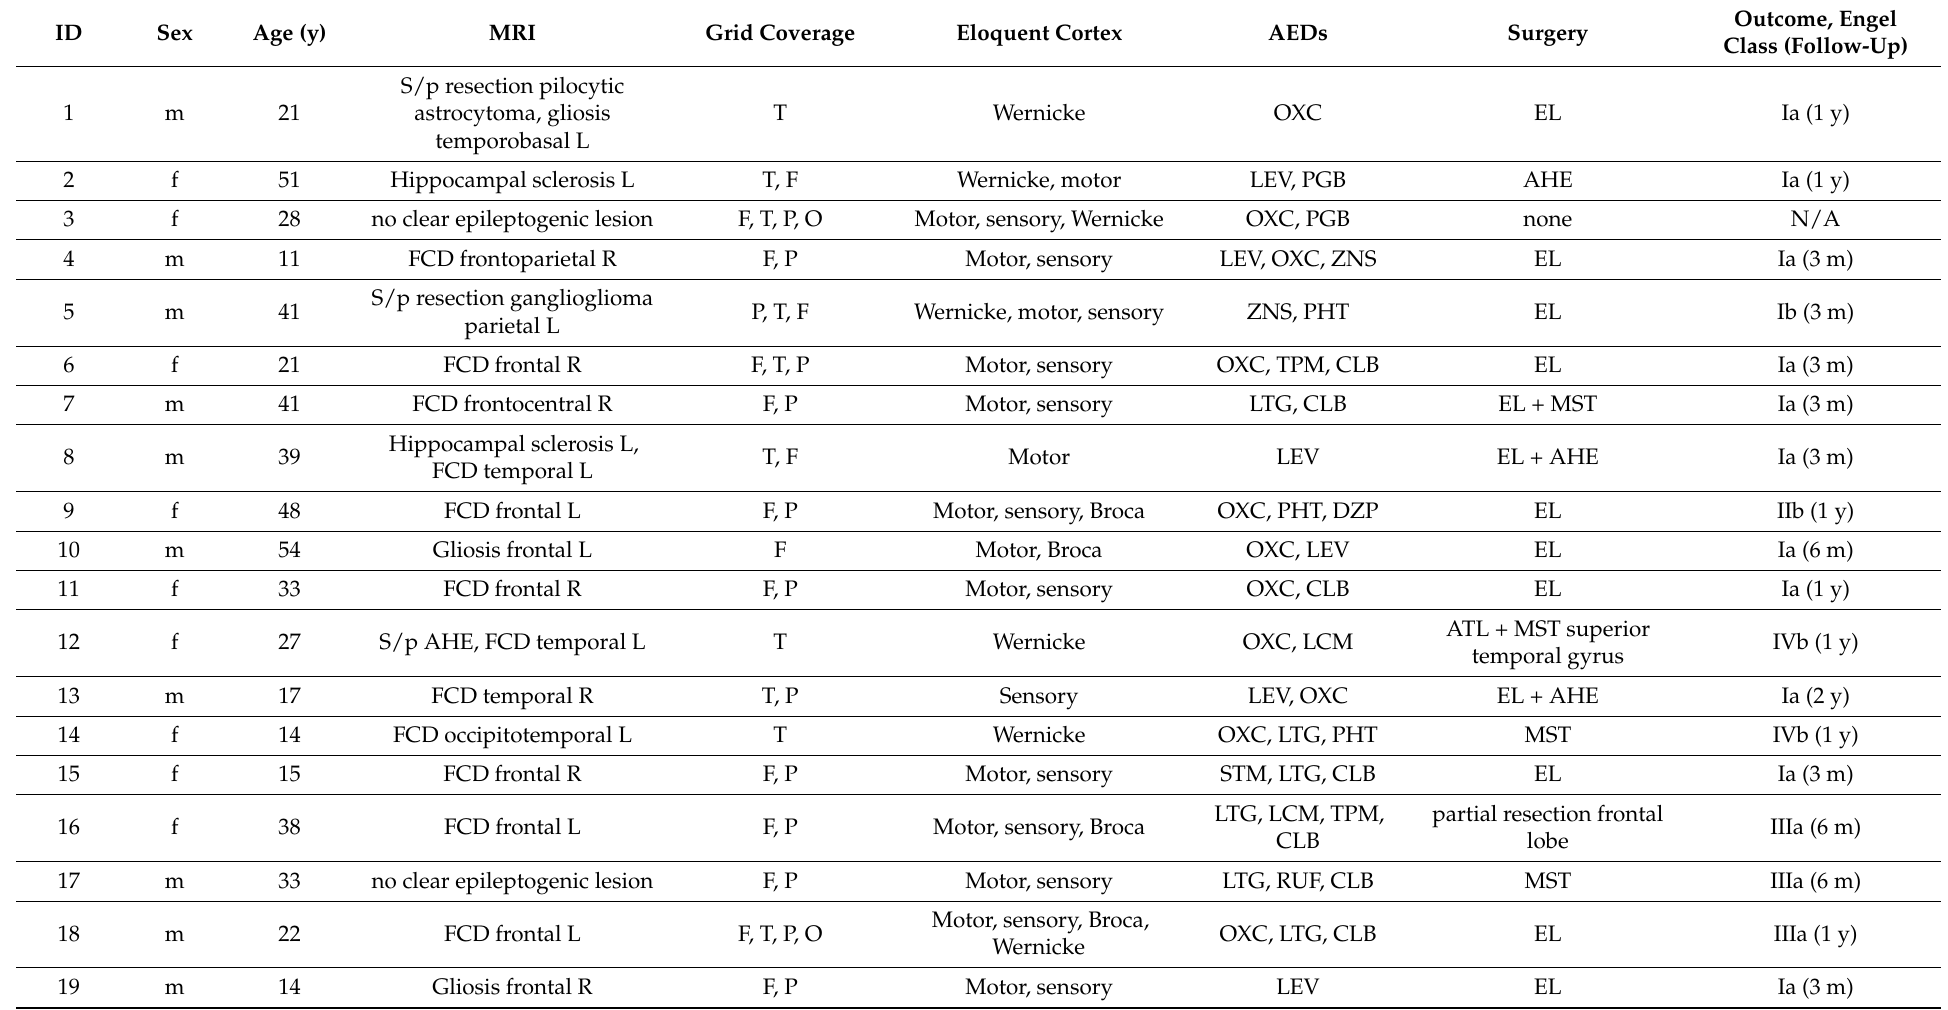
Table 1. Clinical data. Abbreviations: AHE, amygdalohippocampectomy; ATL, anterior temporal lobectomy; EL, extended lesionectomy; F, frontal lobe; f, female; FCD, focal cortical dysplasia; L, left; m, male (second column)/months (last column); MST, multiple subpial trans-sections; P, parietal lobe; O, occipital lobe; R, right; s/p, status post; T, temporal lobe; y,